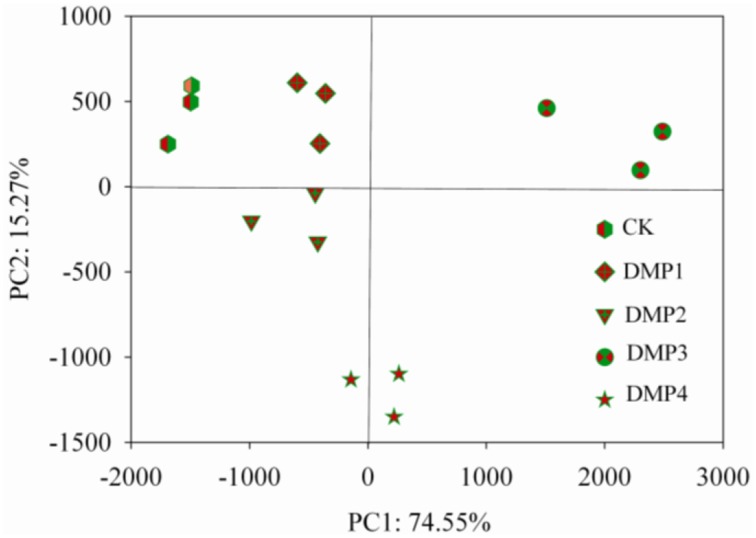
β-diversity analysis of the microbial community across each genus by PCoA for the five DMP treatments (CK, DMP1, DMP2, DMP3, and DMP4) incubated for 25 days in the dark at 25°C and 70% relative humidity.